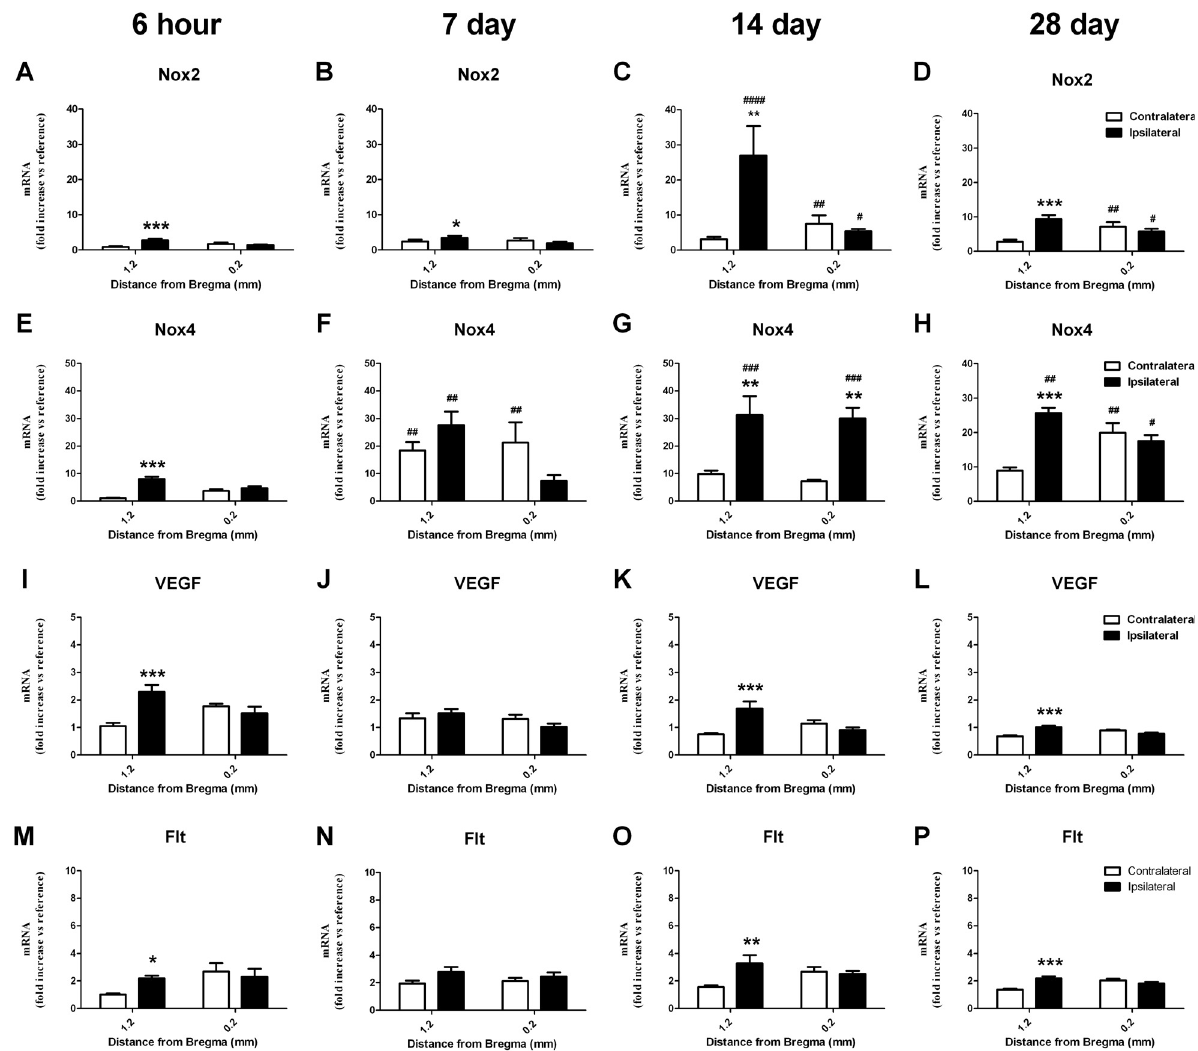
Figure 5. Real-time PCR detection of mRNA for NADPH oxidase subunits, angiogenic factor VEGF and its receptor, Flk, in the striatum 6 h to 28 days after ET-1 induced stroke. Nox2 mRNA expression is increased in the ipsilateral striatum as early as 6 h after stroke and remains elevated for up to 28 days in comparison to the contralateral hemisphere ( A – D ). Nox4 mRNA expression is also increased at 6 h in the ipsilateral striatum and remains elevated for up to 28 days post-stroke, with increases in both the ipsilateral and contralateral hemispheres detected at 7 and 28 days in comparison to the 6 h group ( E – H ). An increase in the angiogenic factor VEGF is detected in the ipsilateral striatum at 6 hand remains elevated for up to 28 days ( I – L ). An increase in VEGF receptor Flt mRNA after stroke is detected 6 h, 14 and 28 days after stroke in the ipsilateral hemisphere ( M – P ). Expression of mRNA was normalized to the respective GAPDH content for each sample ( Δ Ct), then expressed relative to the contralateral side of the brain at 1.2 mm from Bregma, 6 h post-stroke ( ΔΔ Ct). Data are presented as mean SEM of 8 samples per region ( n = 4 per group). * p < 0.05; ** p < 0.01; *** p < 0.001 vs. contralateral; # p < 0.05; ## p < 0.01; ### p < 0.001 vs. corresponding ipsilateral 6 h value; δ p < 0.05 vs. corresponding contralateral 6 h value